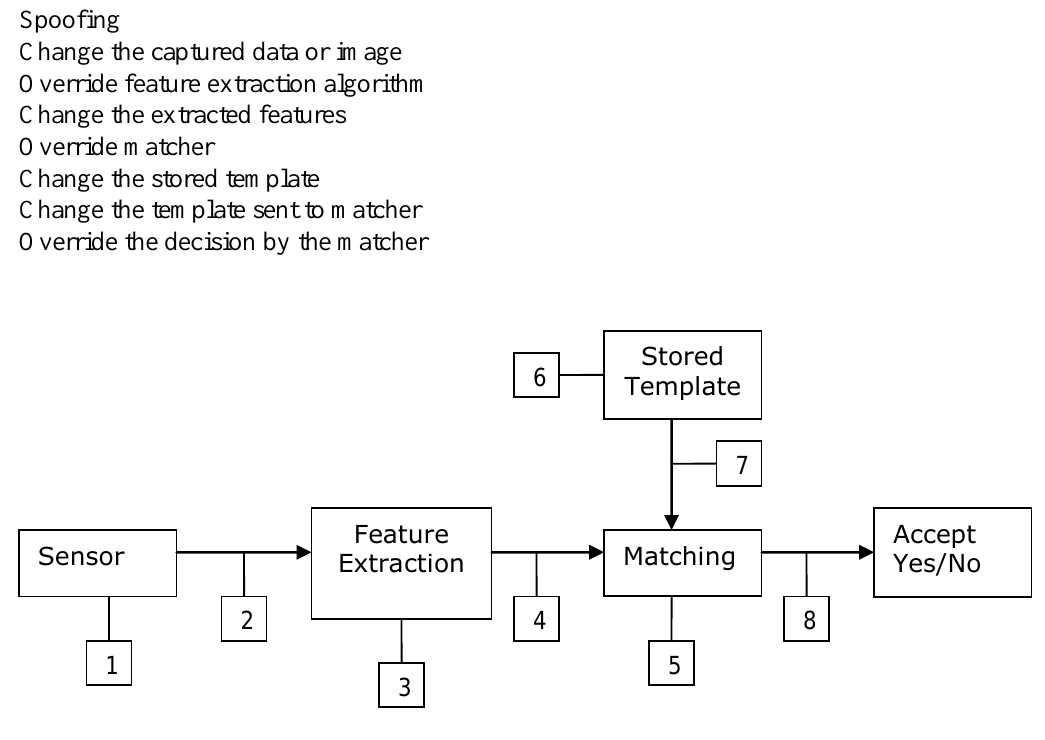
FIGURE 2. The biometric identification